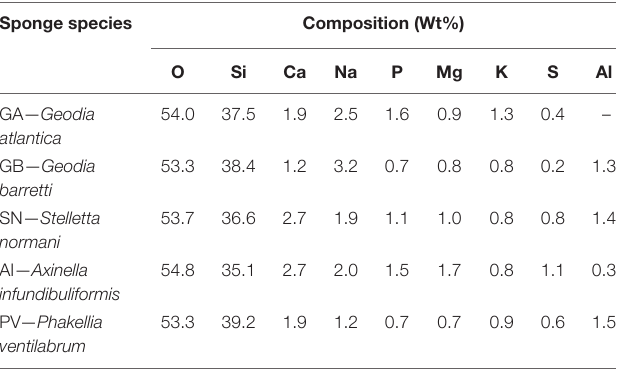
TABLE 1 | Quantification of the chemical elements present in the biosilicas obtained from the different marine sponges. Sponge species